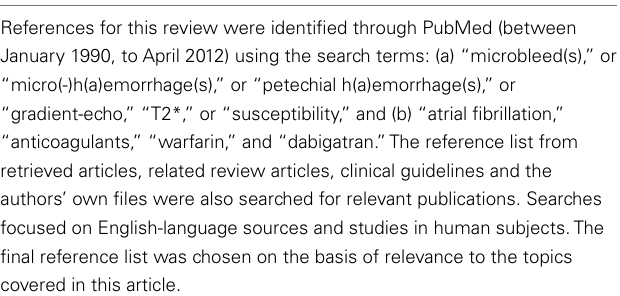
Table 1 | Search strategy and selection criteria.